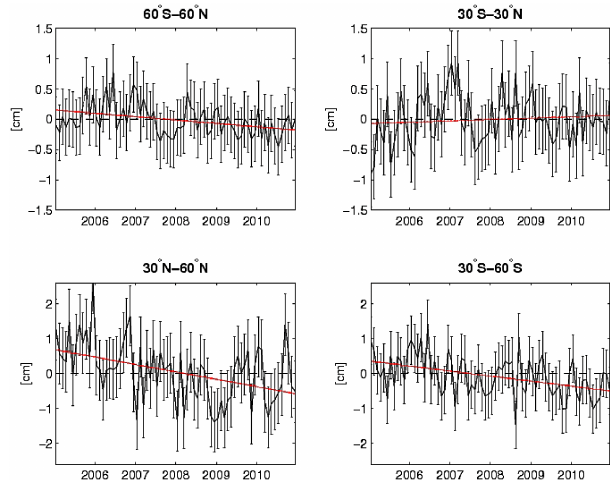
Figure 3. Same as Fig. 2, but using subsampled Altimeter data to quantify biases owing to Argo sampling (see text for more details). Residual trends amount to − 0.6 ± 0.6mmyears − 1 for the global ocean, 0.2 ± 0.7mmyears − 1 for the Tropical Ocean, − 2.1 ± 0.9 for the Northern Ocean, and − 1.5 ± 0.7 for the Southern Ocean. See text for more details on data, method and error